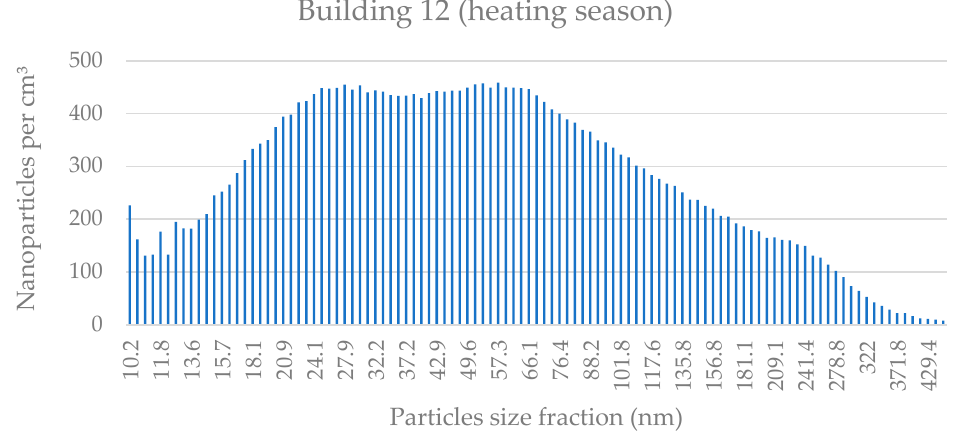
Figure A23. The average nanoparticle concentration in each size fraction in Building 12 during a one-week measurement period during the heating season.